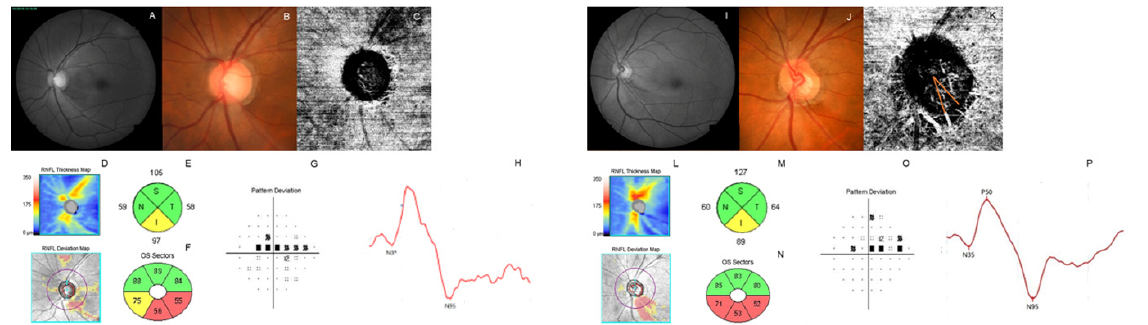
Figure 2. A representative case of comparing patients with MvD and without MvD. A female glaucoma patient (59 years old) without MvD ( C ) presented an inferotemporal RNFL defect ( A , B ) and showed 80 µ m average RNFL thickness and 74 µ m average GCIPL thickness ( D – F ). On her VF test, a central VF defect with MD of − 2.35 dB was shown ( G ). The measured P50 and N95 amplitudes were 3.65 mV and 6.99 mV, respectively ( H ). Another female patient (60 years old) who had an inferotemporal RNFL defect ( I , J ) and MvD ( K ) showed a similar degree of glaucoma severity; MD was − 1.95 dB ( O ), and average RNFL and GCIPL thicknesses were 85 µ m and 70 µ m, respectively ( L – N ). Nevertheless, the amplitudes of P50 and N95 in the patient with MvD were significantly lower (2.66 mV for P50 amplitude and 5.6 mV for N95 amplitude; ( P